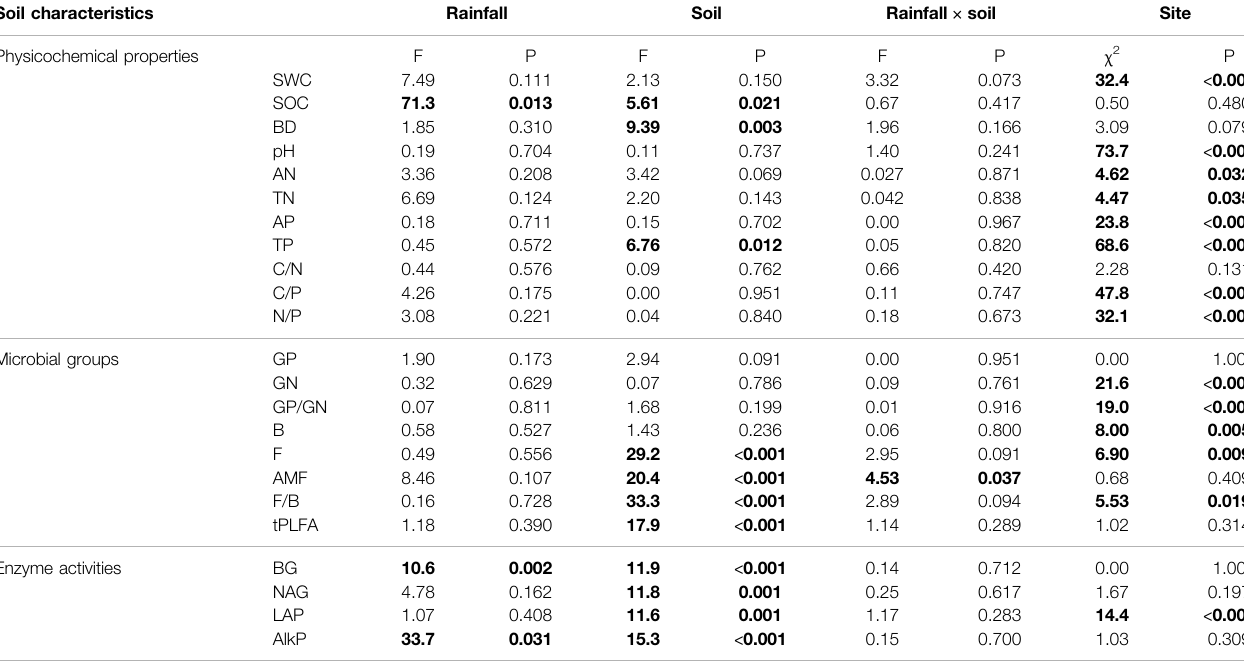
TABLE 2 | Results for the general linear mixed model of soil physicochemical properties, microbial functional groups, and enzyme activities in soils from under- or outside- canopy of shrub species Artemisia gmelinii at sites of varying rates of rainfall in the Minjiang River Valley, SW China.. Soil